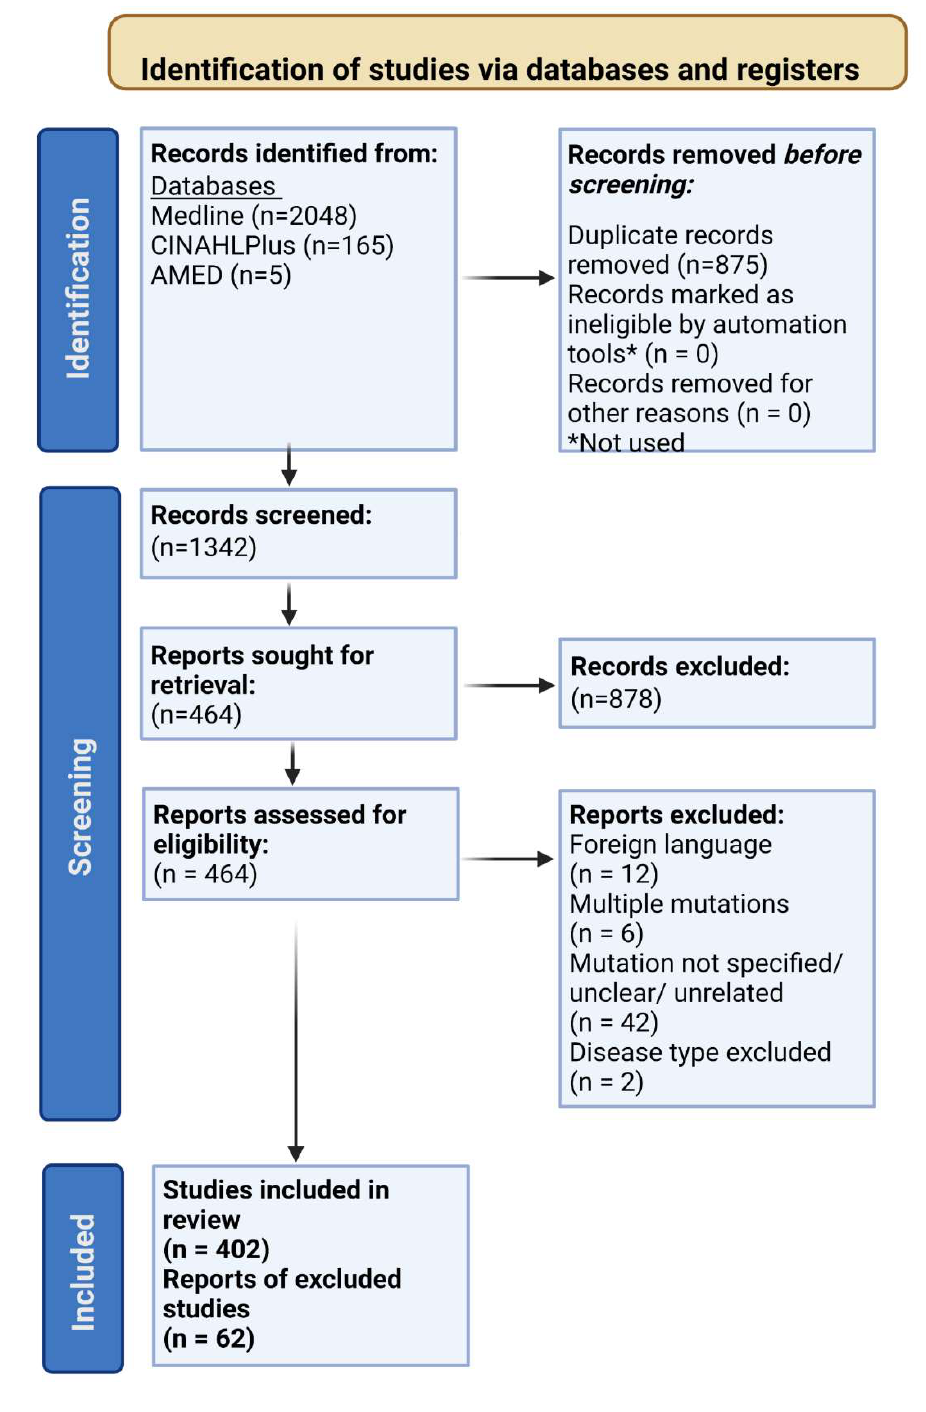
Figure 2. PRISMA flow diagram outlining the search and selection process of identifying records for the systematic review. The databases that were searched were Medline ( n = 2048), CINAHPlus ( n = 165) and AMED ( n = 5), yielding a total of 2218 records. Duplicate records ( n = 875) were removed prior to screening, then 1254 records were subjected to blind screening by two independent reviewers. 878 reports were excluded, and 464 records were retrieved. This left a total of 464 reports that were assessed for eligibility. There were 402 studies that were included in the review, whilst 62 were excluded. Reports were excluded for the following reasons: foreign language ( n = 12), multiple mutations ( n = 6), mutations were not specified, unclear or unrelated ( n = 42) or contained a disease type that was listed within the exclusion criteria ( n = 2). Created with